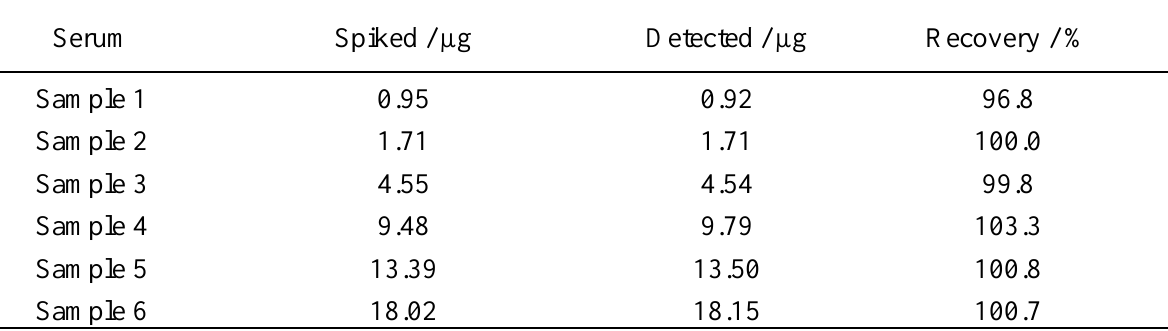
Table 2. Determination of the DA in spiked serum samples with